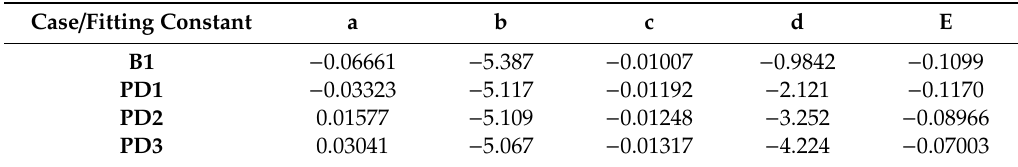
Table 8. Fitting constants for exponential extrapolation of various length combinations of multi-layered stacks.